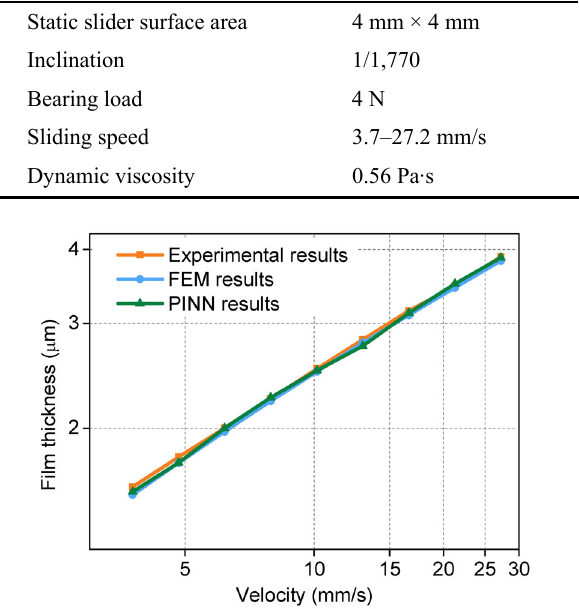
Fig. 13 Outlet film thickness comparison amongst the experimental measurement, FEM calculation, and PINN prediction.